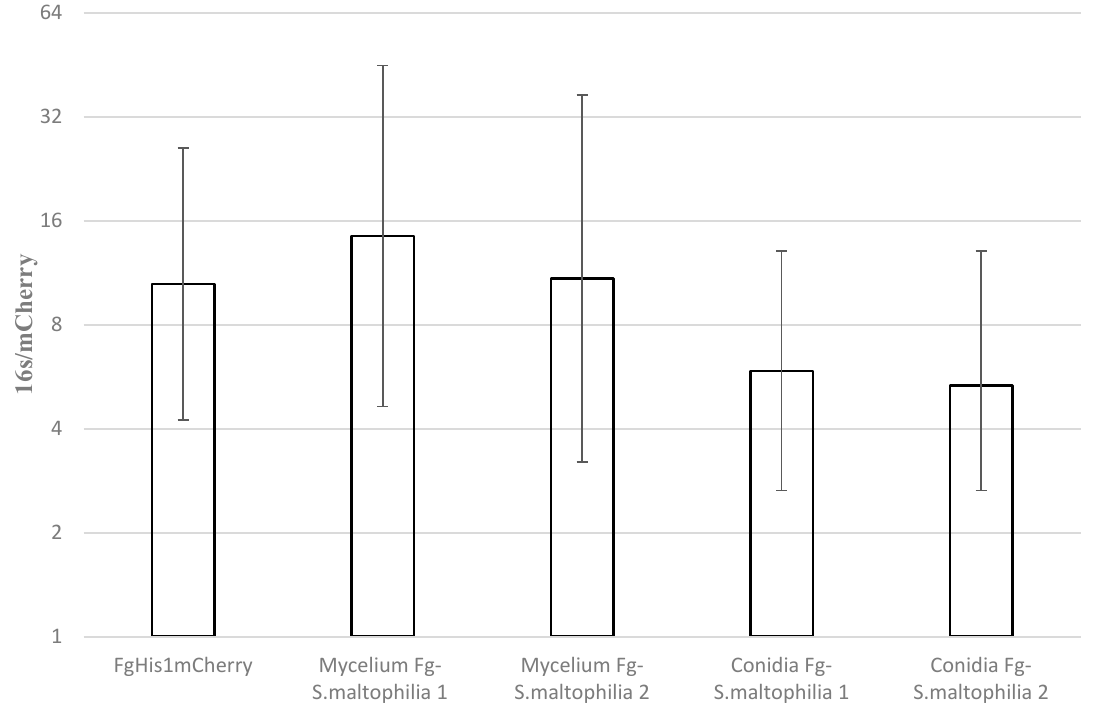
Figure 5. Estimation of S. maltophilia load in Fg- S. maltophilia during coleoptile infection. In vitro on gentamicin (FgHis1mCherry) containing DFM and inside wheat coleoptiles infected with conidia or mycelium of Fg- S. maltophilia isolates and bacterial load estimated using qPCR. Each inoculation method was repeated two times independently with three replicates each time. Error bars show 95% confidence intervals. Non-overlapping confidence interval bars are significantly different ( p same < 0.05). Pairwise t -test comparisons gave the following p values for the probability of different bacterial loads in the fungus in the plant infection compared to the in vitro-grown culture (FgHis1mCherry); mycelium inoculation Fg- S. maltophilia experiment 1 = 0.78, mycelium inoculation Fg- S. maltophilia experiment 2 = 0.98, conidia inoculation Fg- S. maltophilia experiment 1 = 0.61, conidia inoculation Fg- S. maltophilia experiment 2 = 0.57. Since the data are ratios, they are